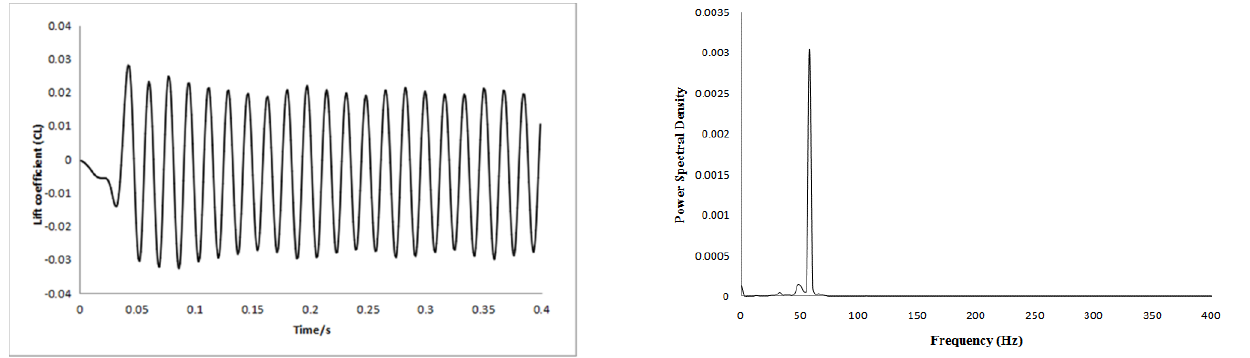
Figure 6. The lift coefficient time history curve and power spectrum curve of the vibration area under the 100% operation mode.